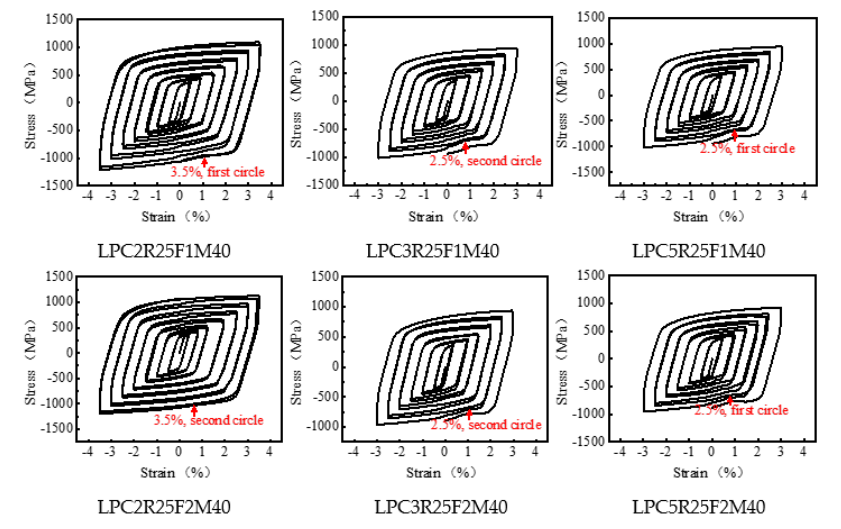
Figure 9. Hysteretic response curves of the proposed LPBRBs.